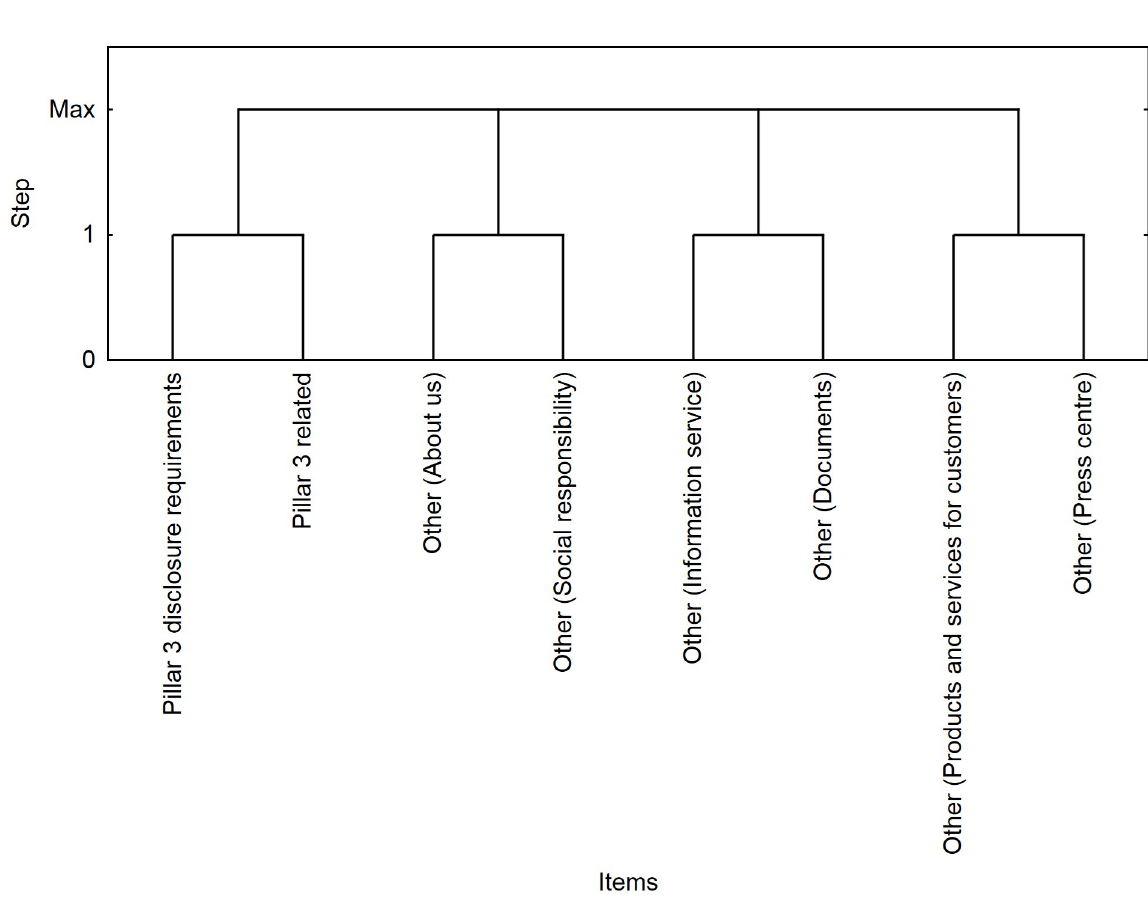
Fig 5. Visualization of segments in the second